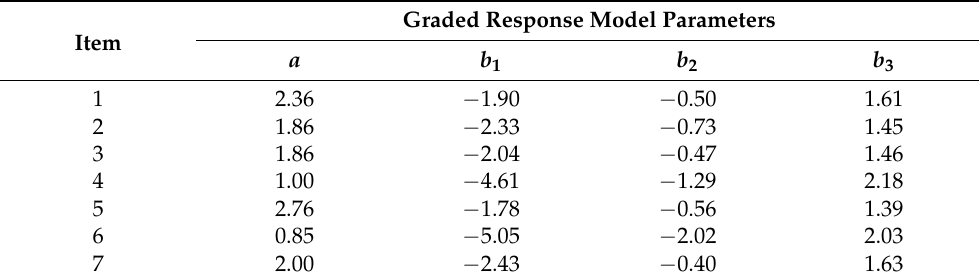
Table 2. Descriptive statistics and graded response model item parameters.